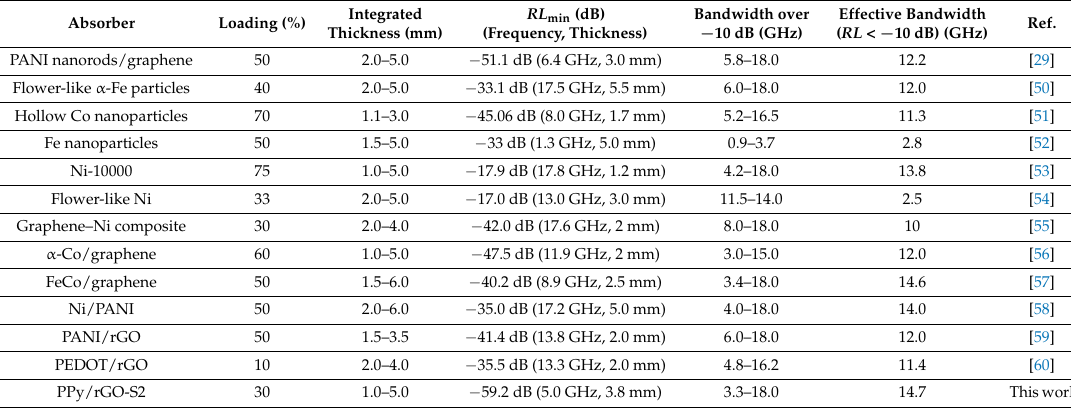
Figure 6. Reflection loss properties of PPy/rGO-S1 ( a ), PPy/rGO-S2 ( b ), and PPy/rGO-S3 ( c ). Table 1. Microwave absorption performance of some magnetic metals, magnetic metal/graphene, magnetic metal/conjugated polymer, and conjugated polymer/graphene absorbers in previous references and this work.